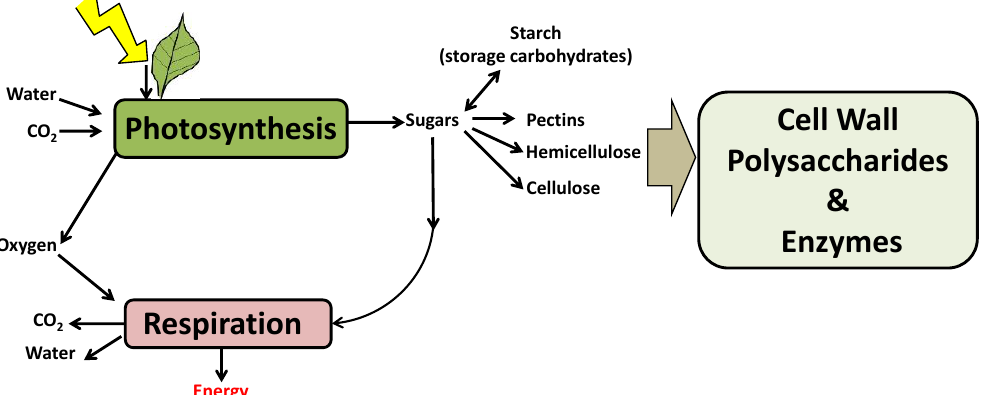
Figure 3. Plants fix atmospheric CO 2 by the photosynthesis process to transform it into organic chemical compounds necessary for their development and growth. Schematic presentation of C metabolism in plant cells towards CW formation (structural role) or, alternatively, towards starch synthesis (storage role). CW biosynthesis is controlled by the photosynthetic rate and C status of the plant. During photosynthesis, light energy transfers electrons from water to fix CO 2 in the chloroplasts via the Calvin cycle to yield sugars. C is directed to starch synthesis in the plastid or directed to CW formation, in the form of cellulose (fibrillar component), or to the CW matrix (pectin and hemicellulose) integrating other CW components such as proteins and lignin. This loop cycle is completed by respiration which occurs when sugars are combined with oxygen and generate useable cellular energy required for growth and normal cell functioning. CO 2 and water are formed as by-products of respiration.